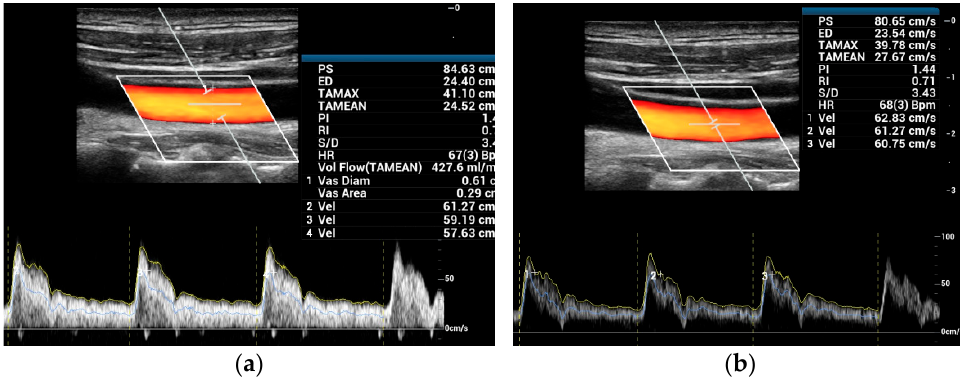
Figure 1. PW measurements: ( a ) big SV covering the vessel for measuring time-averaged mean ve- locity (TAMEAN) and volume flow (Vol Flow); ( b ) small SV for measuring the maximum velocity (PS).